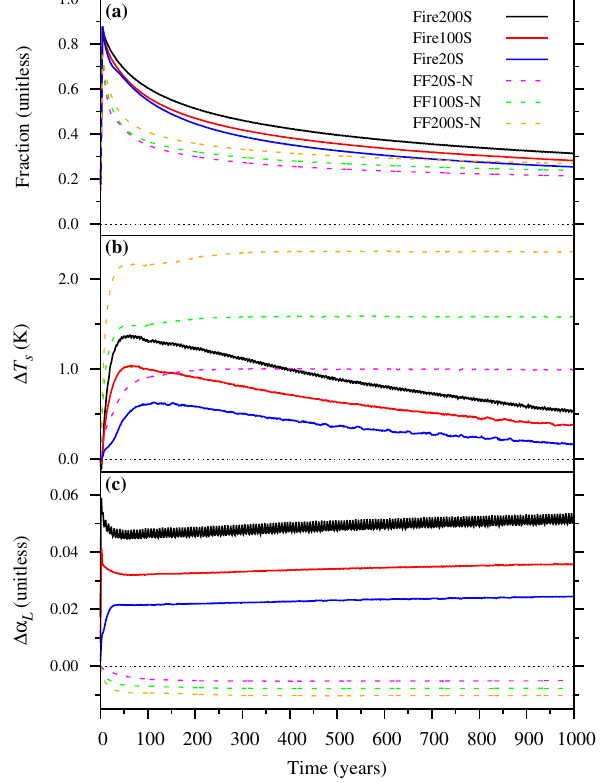
Figure 8. Changes in (a) atmospheric fraction of net cumulative emissions, (b) global mean atmospheric surface temperature, and (c) global mean land surface albedo from the stable regime exper- iments. The fossil fuel emissions were set equal to net yearly fire